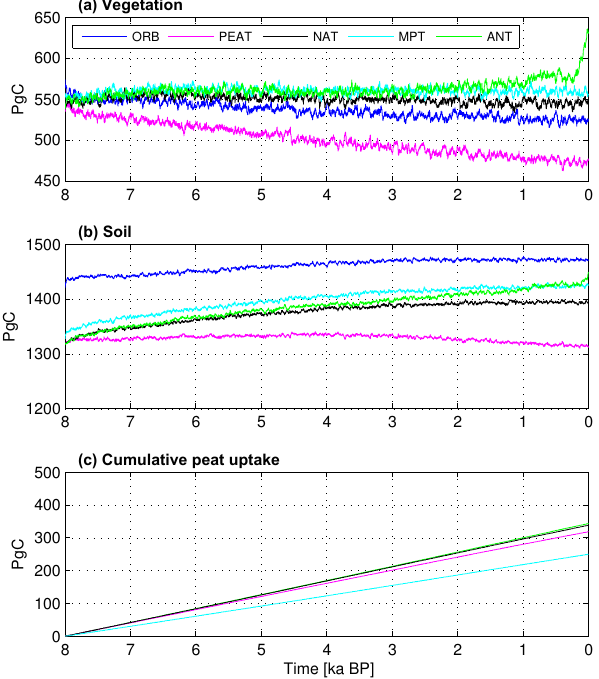
Figure 4. Land carbon pools in Holocene experiments: total veg- etation carbon (a) , total non-peat soil carbon (b) and cumulative C uptake by peatlands (c)